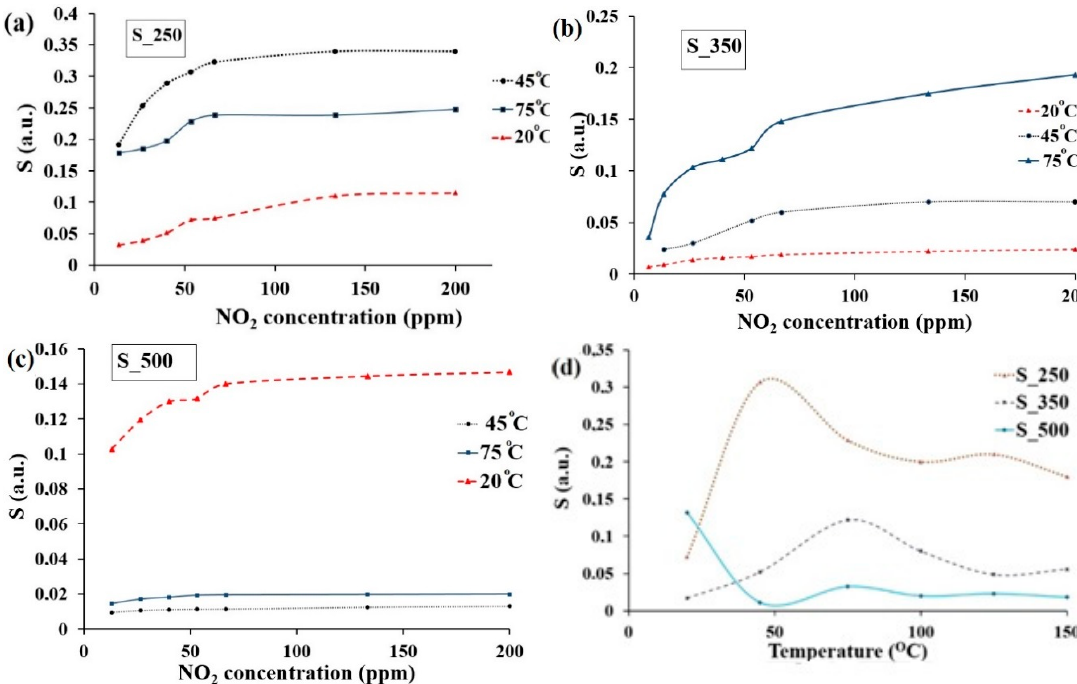
Figure 4. Dependences of sensor response on NO2 concentration at different operating temperatures: (a) S_250 sample, (b) S_350 sample, (c) S_500 sample, (d) dependences of sensor response on operating temperature (NO2 concentration = 53 ppm).